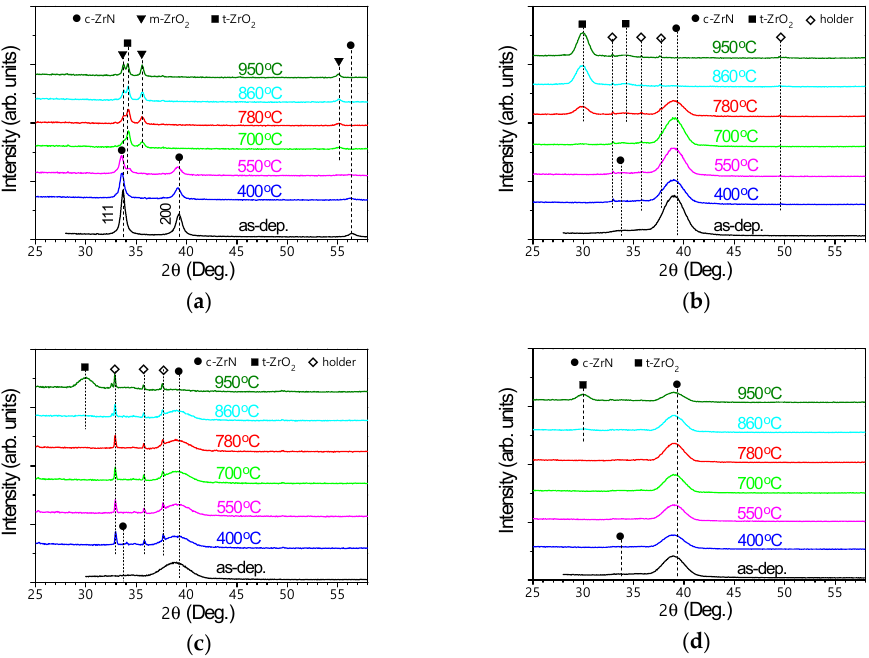
Figure 4. Evolution of XRD patterns under air annealing for ZrN reference film ( a ); and ZrN/SiN x multilayered films with different thickness of ZrN and SiN x elementary layers: ( b ) 5 nm/2 nm; ( c ) 5 nm/5 nm; and ( d ) 5 nm/10 nm.